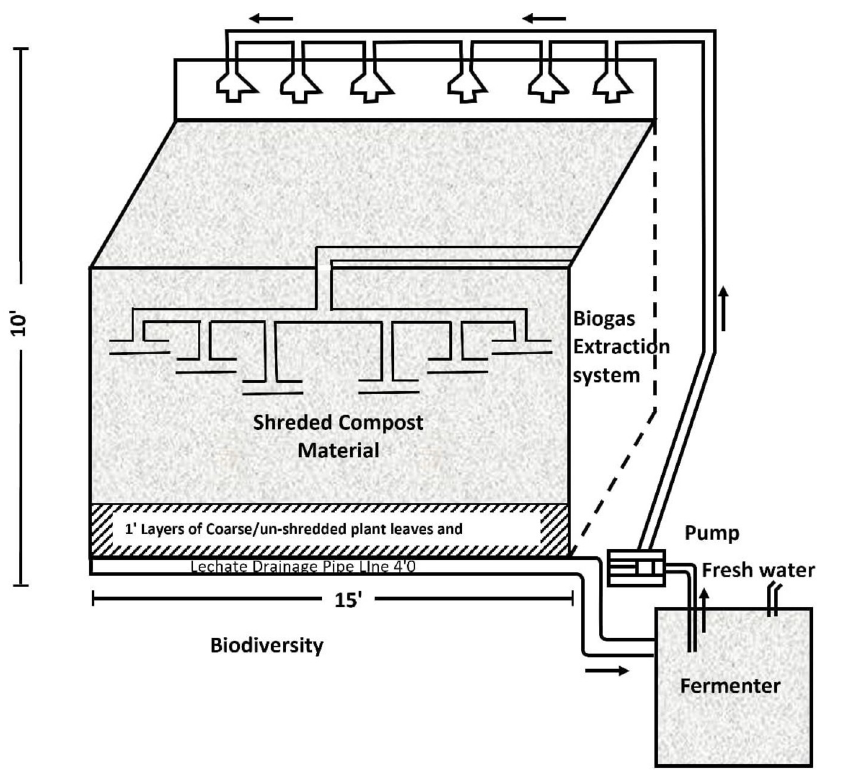
Fig 1. Schematic diagram of the system used for